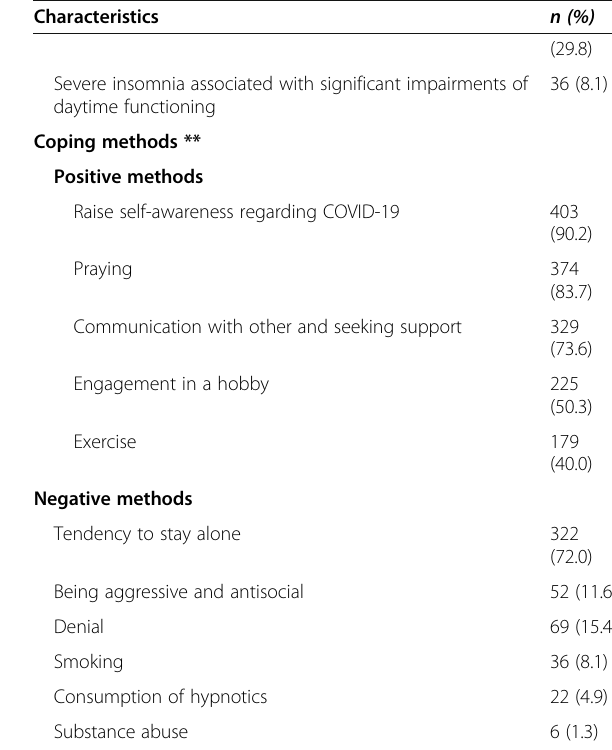
Table 1 Characteristics of the study participants ( n = 447) Characteristics